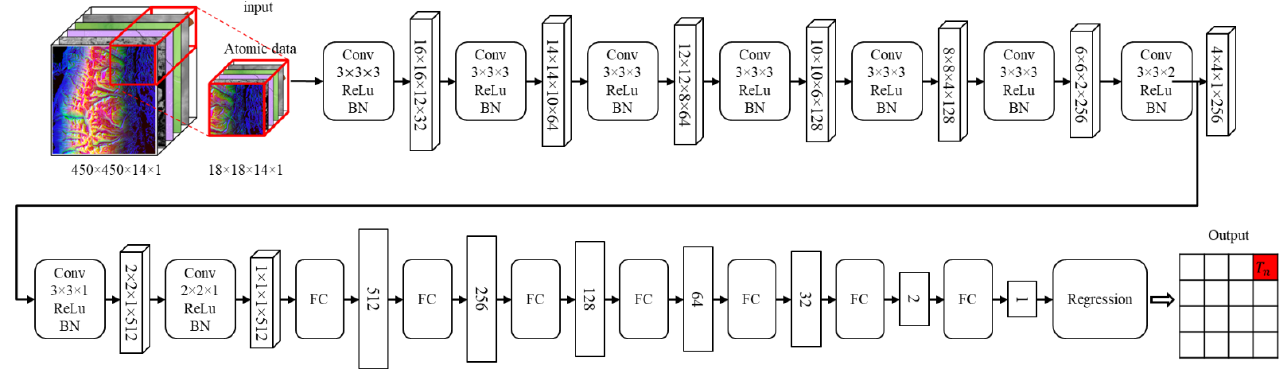
Figure 5. An example of the CNN-based machine learning model for the computing load prediction.